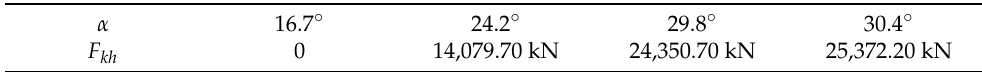
Table 3. The relationship between F kh and limit angle α